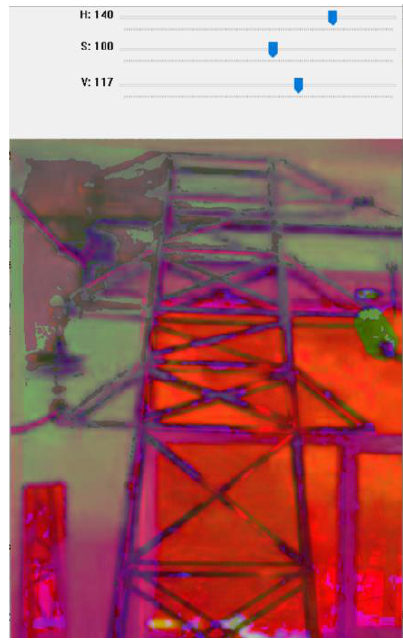
Figure 6. Mask the HSV result.